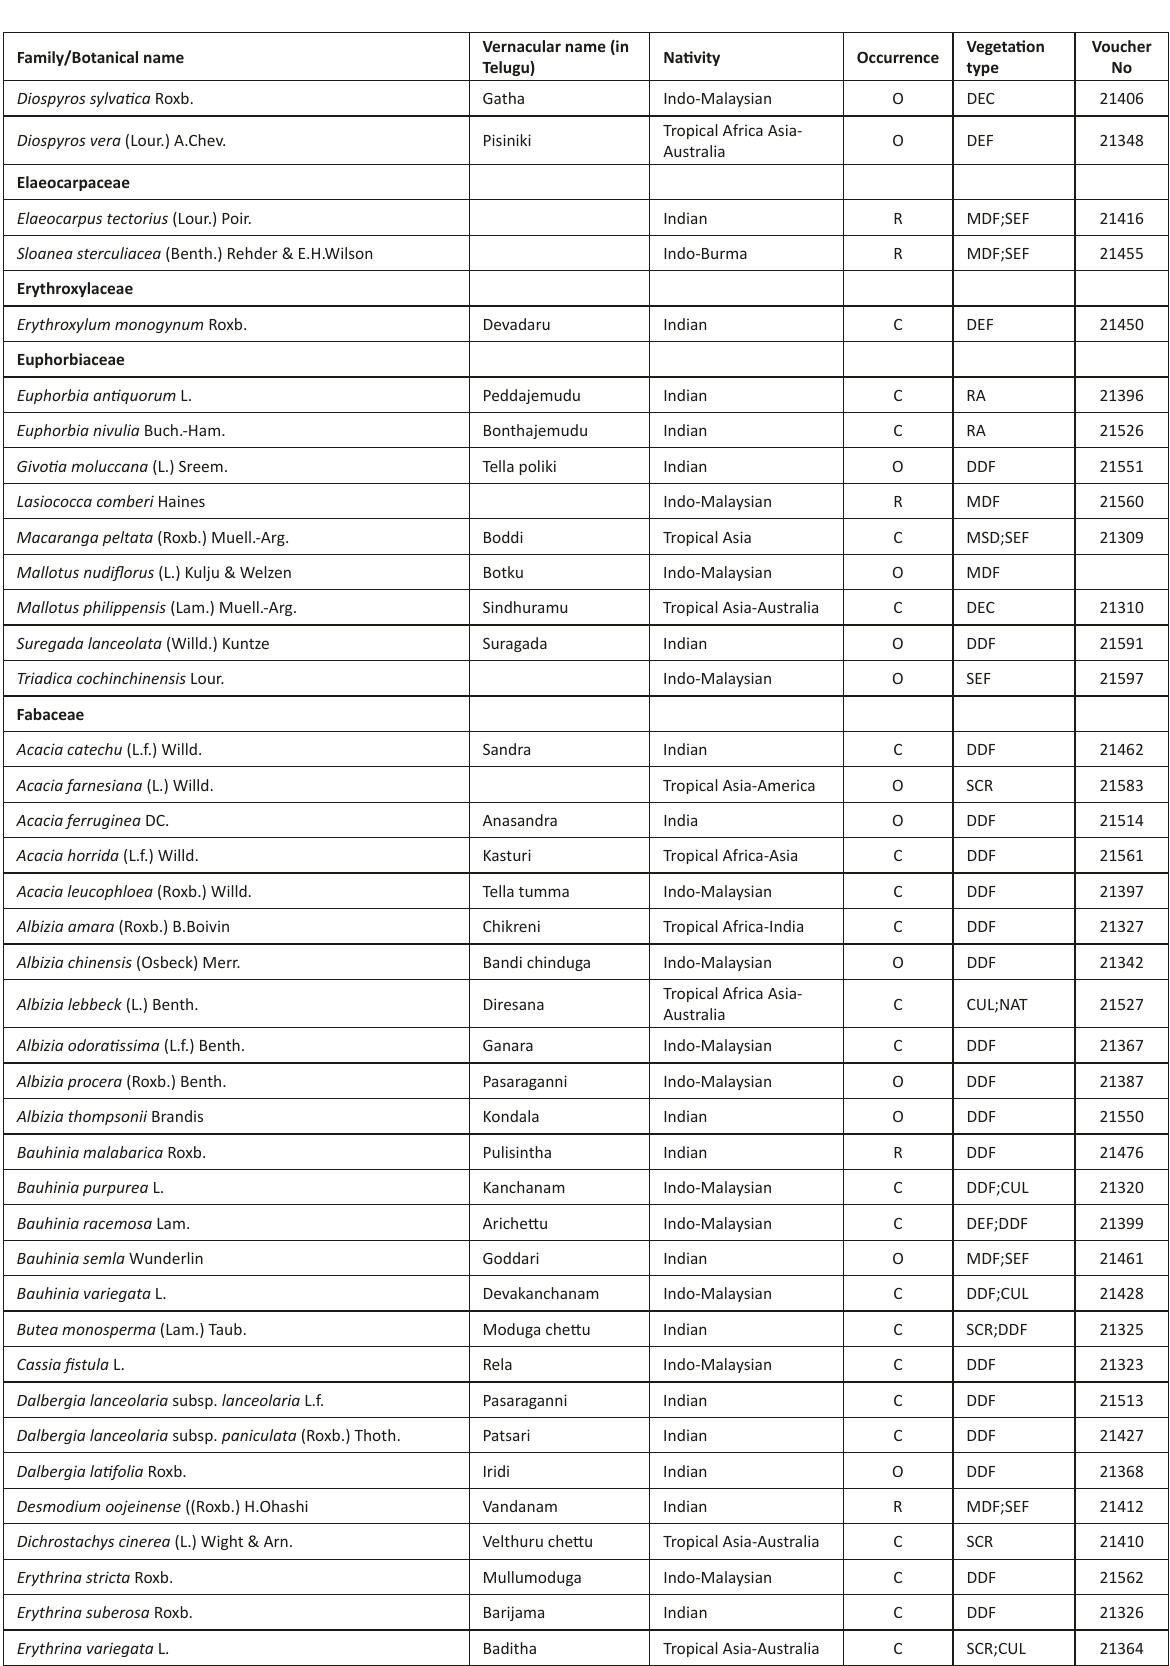
Dalbergia lanceolaria subsp. lanceolaria